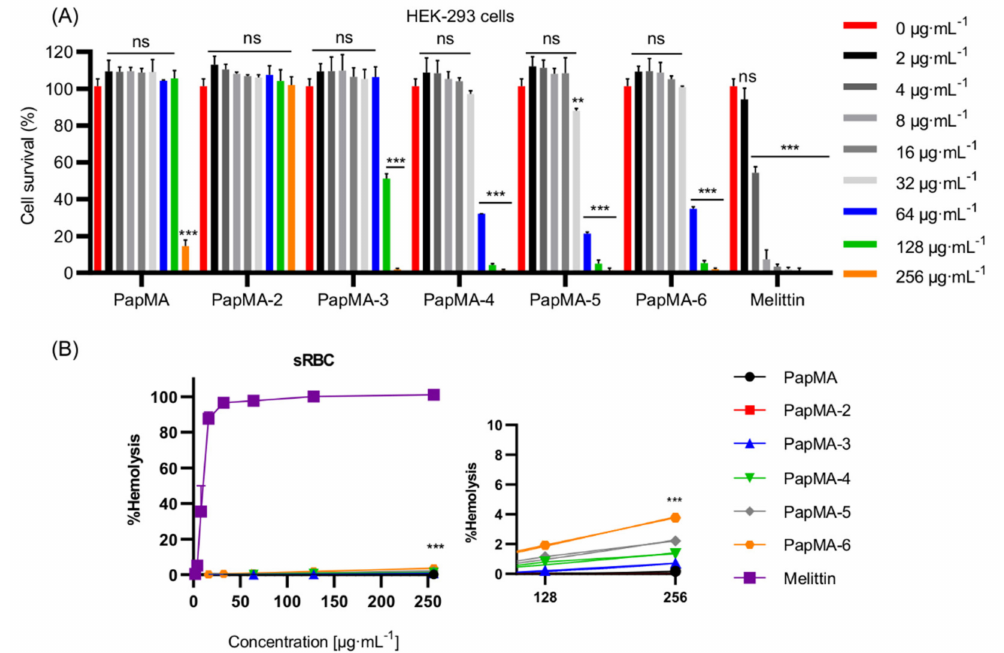
Figure 4. Cytotoxicity of PapMA analogs. ( A ) Cytotoxicity of PapMA and its analogs against HEK-293 cell. The peptide was serially diluted and incubated with cells for 24 h. ( B ) Hemolysis activity of PapMA analogs against sRBC. The peptide was serially diluted and incubated with sRBC for 1 h with melittin as a control. Statistical analysis was performed using two-way ANOVA with Dunnett’s comparison test. The values are expressed as the mean ± SEM of three independent experiments and are statistically significant at ** p < 0.01; and *** p < 0.001. ns, not